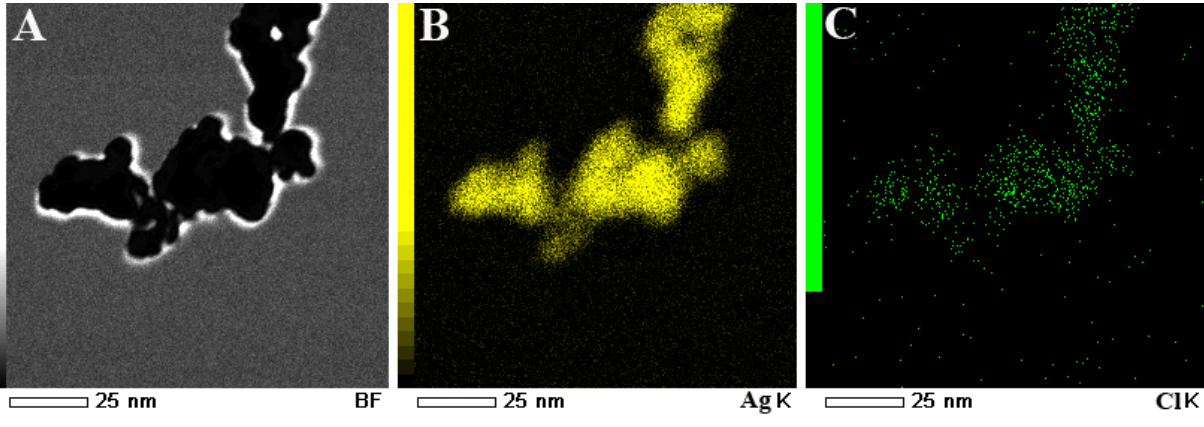
Figure 4. TEM-Energy Dispersive Spectroscopy (EDS) mapping of Ag/AgCl composites. ( A ) TEM image; ( B ) Mapping of Ag; ( C ) Mapping of